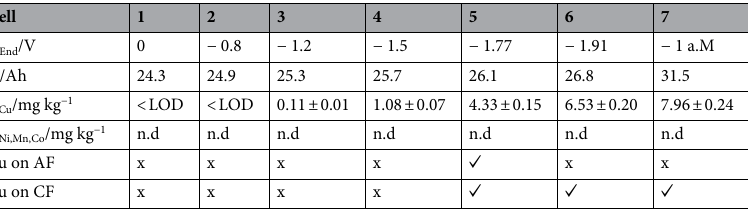
Table 1. Analysis of electrolyte (w Cu , w Ni,Mn,Co ) and visual inspection of anode (AF) and cathode (CF) foils, x → not present, ✓ → present; U End is the voltage drop across the battery at electrolyte withdrawal, Q is the amount of charge withdrawn from the circuit, cell 7 a.M. after the minimum, LOD Cu = 0.01 mg kg −1 , n.d. → not detectable.